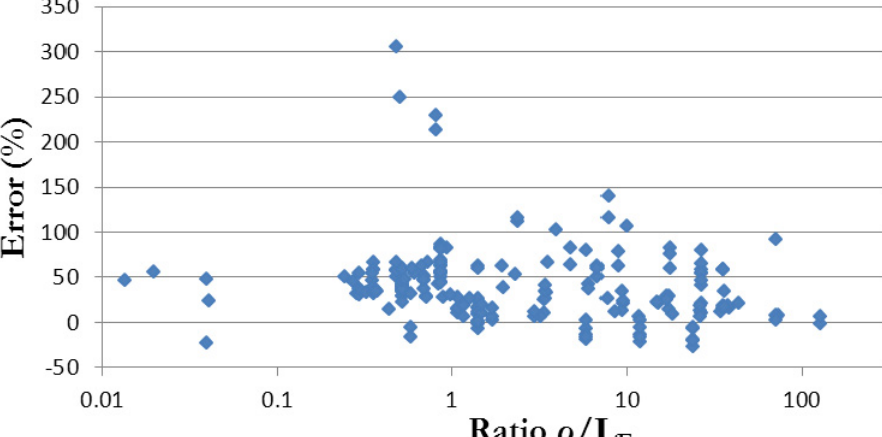
Figure 5: Error % against ratio of notch root radius, ρ , and the critical distance, L E (local stress fields post-processed in terms of maximum principal